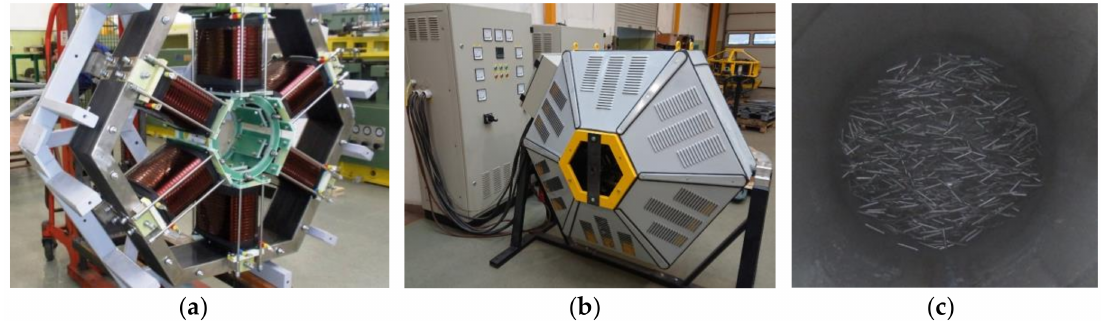
Figure 2. Construction of electromagnetic mill: ( a ) electromagnets; ( b ) the mill with the cover and supply cabinet; ( c ) working chamber with the grinding media during